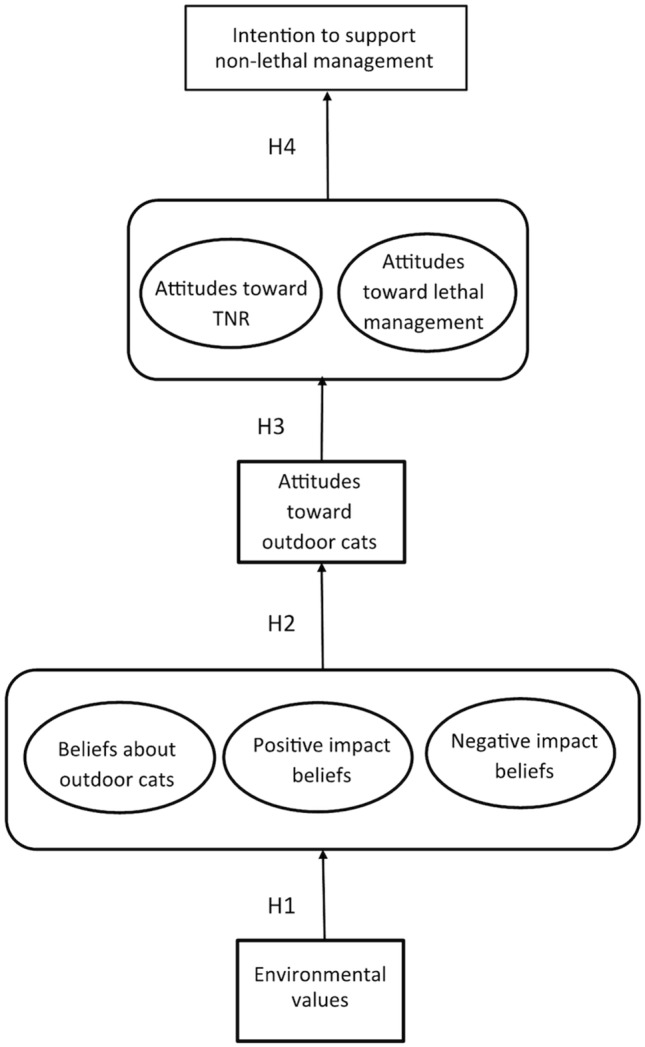
A theoretical model predicting intentions to support cat management.A theoretical model, based on the cognitive hierarchy, illustrating the hypothesized relationships between values, beliefs, attitudes and behavioral intentions. Each of the latent variables (represented by circles) is based on responses to a series of Likert-scale questions (Table 1).